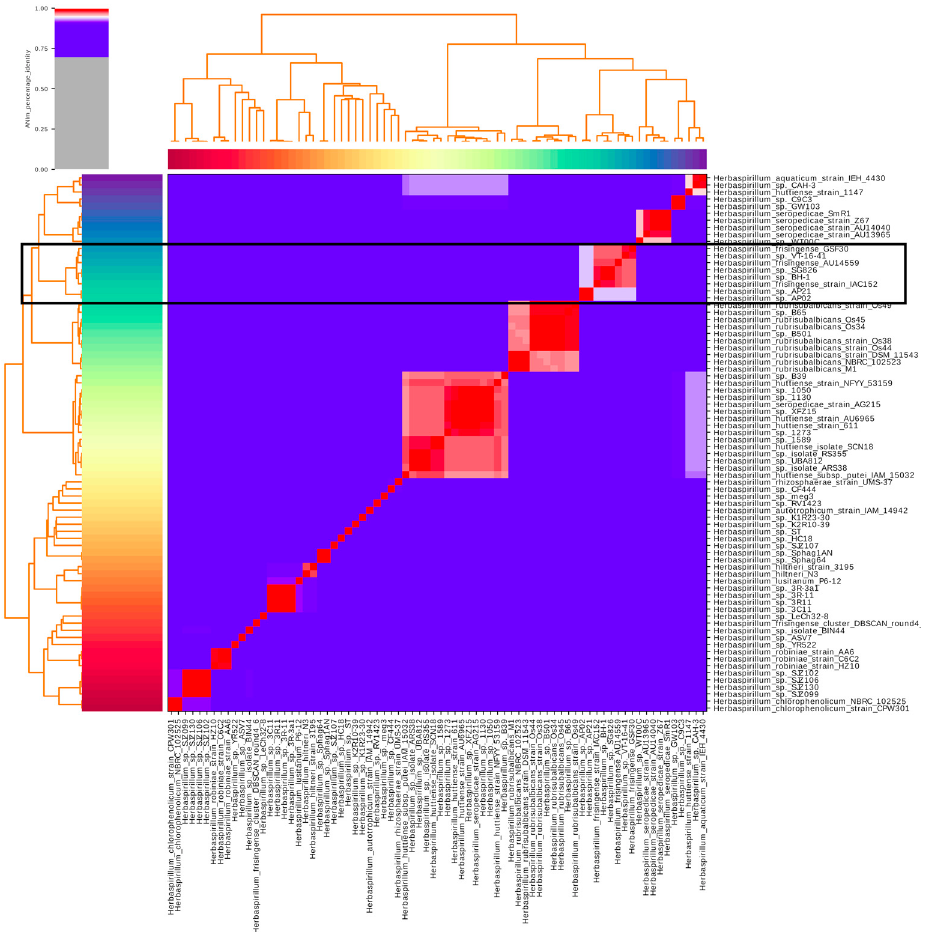
Figure 1. Average nucleotide identity heatmap (ANI) among all genomes of the genus Herbaspirillum deposited at NCBI. The ANIs were calculated by the pyani pipeline after aligning the regions present in all genomes of the genus Herbaspirillum through the Mummer. Genomes with ANI higher than 95% can be considered to belong to the same species; this identified the AU14559 isolate, as well as the strains Herbaspirillum sp BH-1 and Herbaspirillum sp SG826, as belonging to the species Herbaspirillum frisingense .